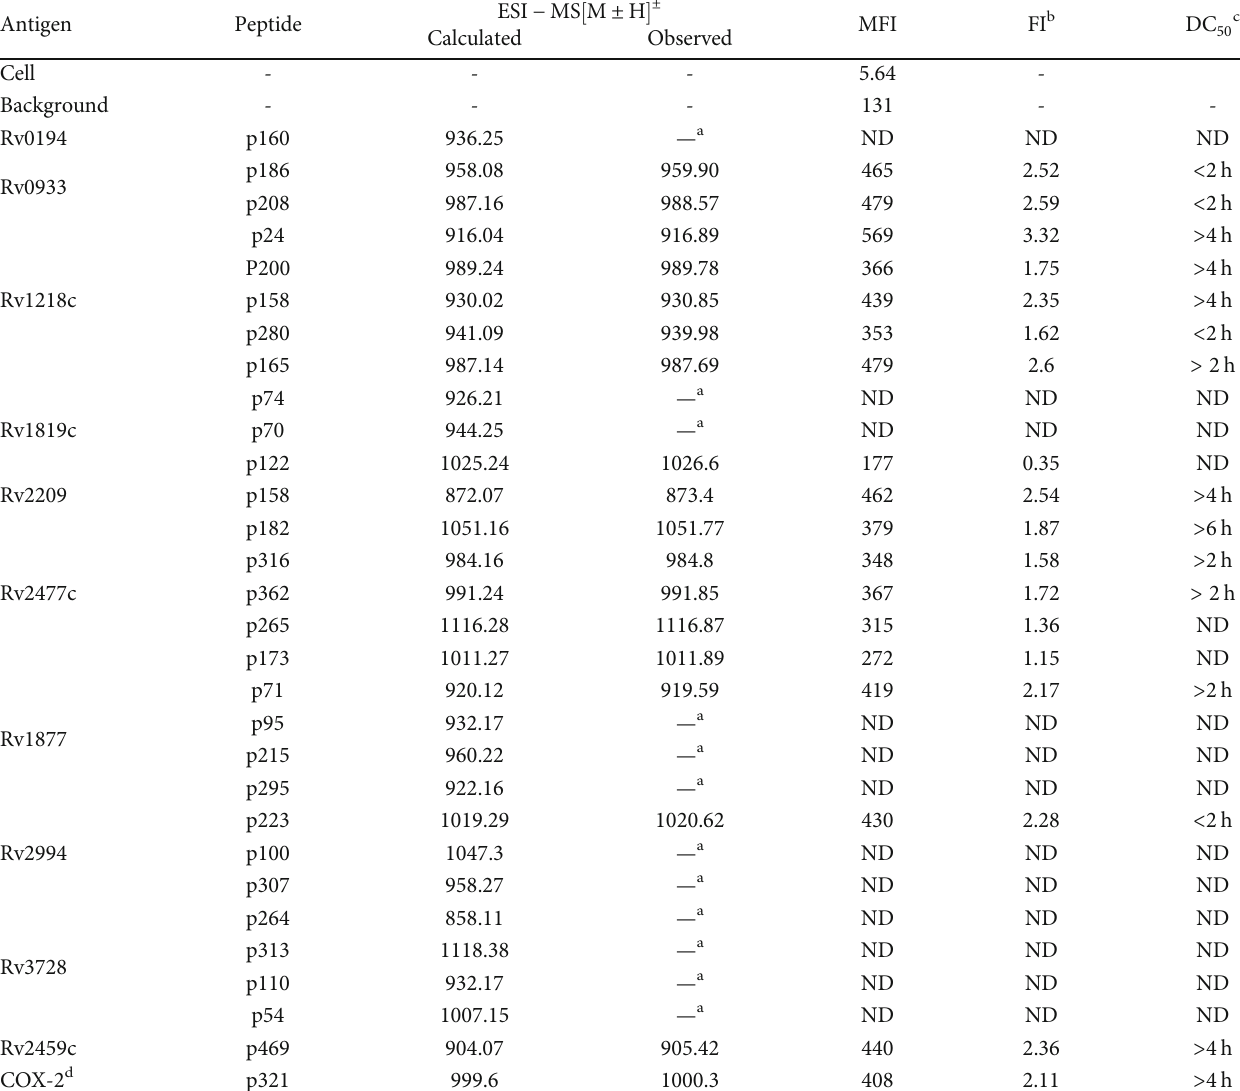
Table 2: The data of ESI-MS and the binding a ffi nity and stability of peptide/HLA-A ∗ 0201 complex. Antigen